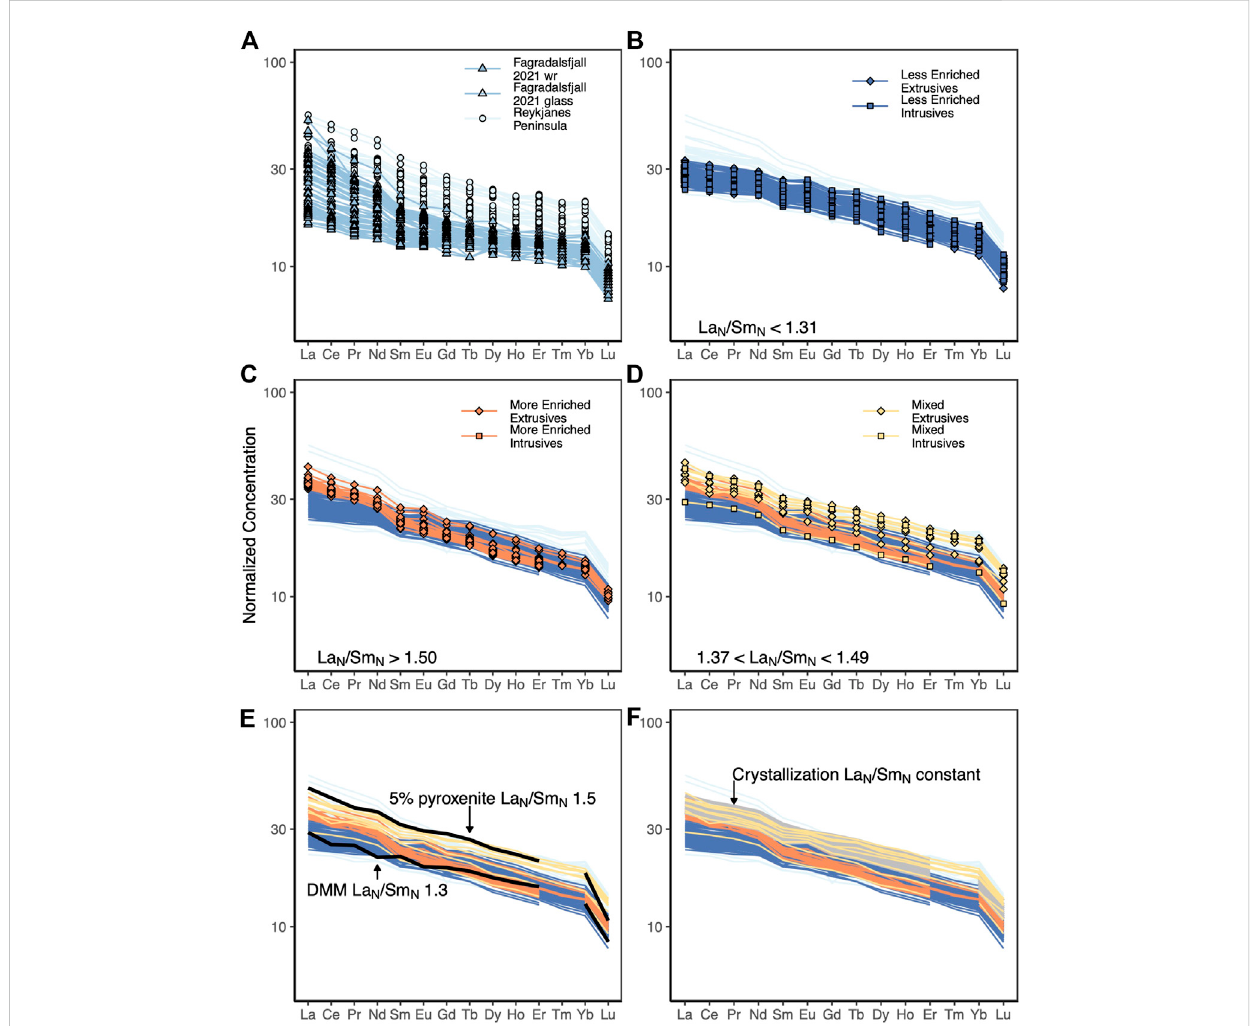
FIGURE 7 Rare Earth element (REE) concentrations normalized to chondrite values from McDonough and Sun (1995). (A) Reykjanes Peninsula (light blue circles), including the Fagradalsfjall 2021 eruption (medium blue triangles). Undirhlíðar ridge extrusive (diamonds) and intrusive (squares) samples shown in (B – D) , grouped by La N /Sm N values: (B) La N /Sm N < 1.31 (less enriched), (C) La N /Sm N > 1.50 (more enriched), (D) 1.37 < La N /Sm N < 1.49 (mixed). (E) Black linesshowalphaMELTSmodelmeltcompositionsfordepleted(DMM)andenriched(5%pyroxenite)mantlesources,illustratinghowmixingbetween two mantle source compositions can generate the Undirhlíðar ridge data. (F) Gray fi eld show alphaMELTS model liquid compositions for up to 30% fractional crystallization illustrating how variable extents of crystallization affect REE abundance. See text for model details. Undirhlíðar ridge data